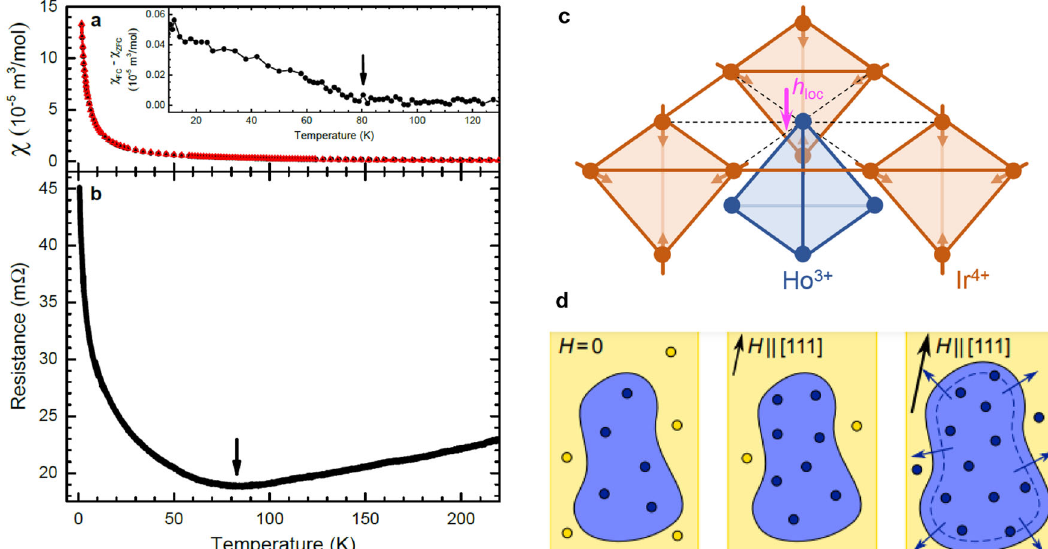
Fig. 1 Iridium ordering and metal-insulator transition in single-crystalline Ho 2 Ir 2 O 7 . a Field-cooled (red open triangles) and zero- fi eld-cooled (black fi lled circles) magnetic susceptibility measured in a 0.01 T [100] magnetic fi eld. Inset: Field-cooled magnetic susceptibility with the zero- fi eld-cooled measurement subtracted. The ordering of the Ir moments at approximately 80 K is indicated by the arrow. b Resistance measured under zero applied fi eld, exhibiting a MIT at approximately 80 K, indicated by the arrow. c Schematic of the pyrochlore structure of Ho 2 Ir 2 O 7 , in which each Ho 3 + ion (blue) has six Ir 4 + (orange) nearest neighbours. The long-range magnetic order of the Ir moments (orange arrows) results in a net local effective fi eld at the Ho sites ( h loc ) aligned either parallel or antiparallel to the local 〈 111 〉 directions (indicated here by the magenta arrow for the uppermost Ho site) 14 . d Cartoon showing the two possible Ir antiferromagnetic domains (blue/yellow regions) and the different types of Ho monopole crystal order (blue/yellow circles). At zero fi eld, Ho — Ir interactions introduce a fi nite density of monopoles, consistent with a 3I1O/1I3O monopole crystal, which lowers the local interaction energy (left). Here, the colour of the monopole crystal matches the domain in which it is energetically favoured by the Ho — Ir interaction. An external magnetic fi eld along the [111] direction favours one Ho monopole crystal over the other — say the one in the blue domain, causing the density to increase; in the yellow domain, the density is conversely depleted (centre) but still keeps the domain metastable. A suf fi ciently strong [111] fi eld, however, repolarises the monopoles in the yellow domain, making it favourable for the blue domain to grow into the yellow one